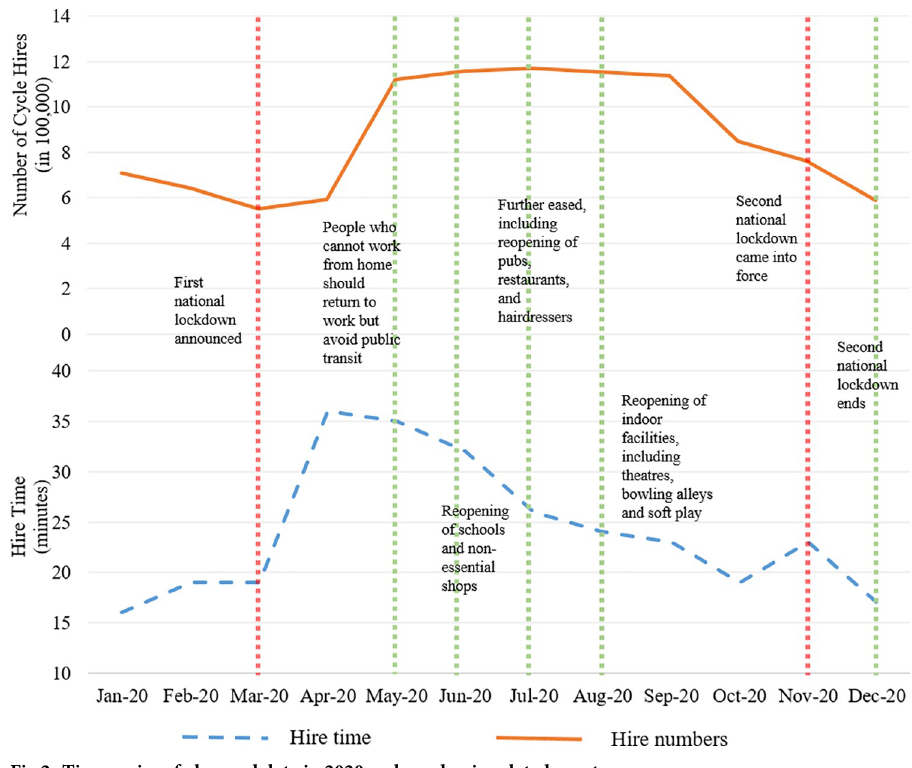
Fig 2. Time-series of observed data in 2020 and pandemic-related events.